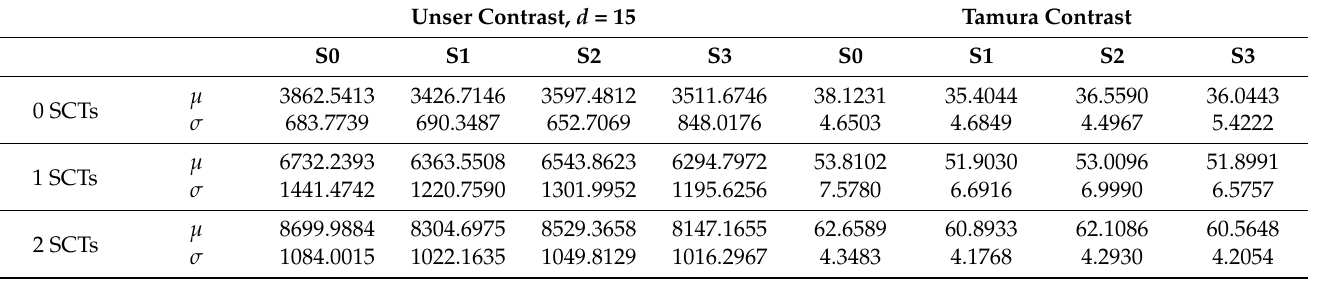
Table 1. Mean ( µ ) and standard deviation ( σ ) for the contrast values, different load combinations, and different SCT fault conditions.